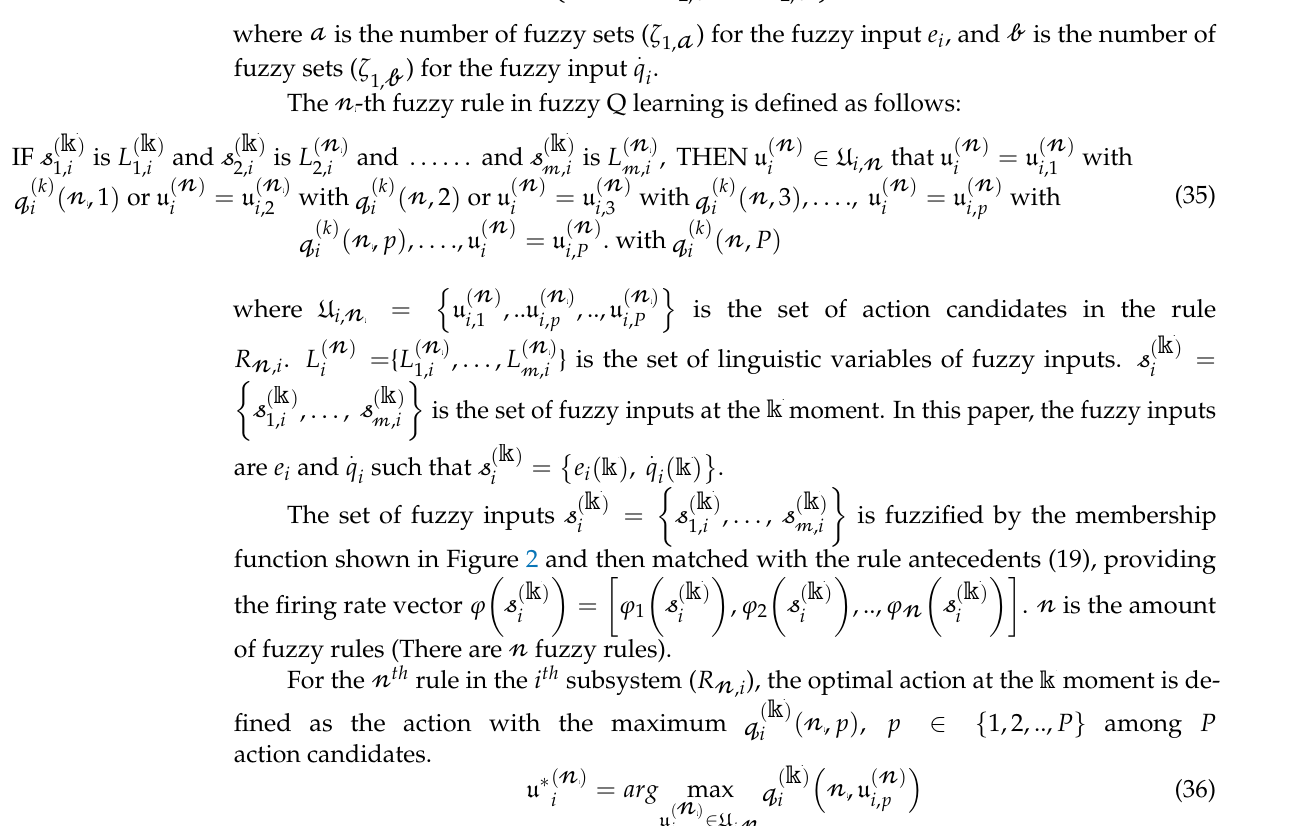
Figure 2. Membership function of fuzzy input of the 𝑖 (cid:3047)(cid:3035) subsystem. The parameters of membership function shown in Figure 2 are defined as follows: 𝐿𝑖𝑛(𝑒 (cid:3036) ) = (cid:4676)𝜁 (cid:2869),(cid:2869)((cid:3036)) , … , 𝜁 (cid:2869),𝒶((cid:3036)) , … , 𝜁 (cid:2869),𝒜((cid:3036)) (cid:4677), 𝒶 = 1,2, … , 𝒜 (33) 𝐿𝑖𝑛(𝑞(cid:4662) (cid:3036) ) = (cid:4676)𝜁 (cid:2870),(cid:2869)((cid:3036)) , … , 𝜁 (cid:2870),𝒷((cid:3036)) , … , 𝜁 (cid:2870),ℬ((cid:3036)) (cid:4677), 𝒷 = 1,2, … , ℬ (34) where 𝒜 is the number of fuzzy sets ( 𝜁 (cid:2869),𝒶 ) for the fuzzy input 𝑒 (cid:3036) , and ℬ is the number of fuzzy sets ( 𝜁 (cid:2869),𝒷 ) for the fuzzy input 𝑞(cid:4662) (cid:3036) . The 𝓃 -th fuzzy rule in fuzzy Q learning is defined as follows: 𝑅 𝓃,(cid:3036) : IF 𝓈 (cid:2869),(cid:3036)(𝕜) is 𝐿 (cid:2869),(cid:3036)(𝕜) and 𝓈 (cid:2870),(cid:3036)(𝕜) is 𝐿 (cid:2870),(cid:3036)(𝓃) and …… and 𝓈 𝓂,(cid:3036)(𝕜) is 𝐿 𝓂,(cid:3036)(𝓃) , THEN 𝔲 (cid:3036)(𝓃) ∈ 𝔘 (cid:3036),𝓃 that 𝔲 (cid:3036)(𝓃) = 𝔲 (cid:3036),(cid:2869)(𝓃) with 𝓆 (cid:3036) ( (cid:3038) ) (𝓃, 1) or 𝔲 (cid:3036) ( 𝓃 ) = 𝔲 (cid:3036),(cid:2870) ( 𝓃 ) with 𝓆 (cid:3036) ( (cid:3038) ) (𝓃, 2) or 𝔲 (cid:3036) ( 𝓃 ) = 𝔲 (cid:3036),(cid:2871) ( 𝓃 ) with 𝓆 (cid:3036) ( (cid:3038) ) (𝓃, 3) ,…., 𝔲 (cid:3036) ( 𝓃 ) = 𝔲 (cid:3036),(cid:3043) ( 𝓃 ) with 𝓆 (cid:3036)((cid:3038)) (𝓃, 𝑝) ,…., 𝔲 (cid:3036)(𝓃) = 𝔲 (cid:3036),(cid:3017)(𝓃) . with 𝓆 (cid:3036)((cid:3038)) (𝓃, 𝑃) (35) where 𝔘 (cid:3036),𝓃 = (cid:4676)𝔲 (cid:3036),(cid:2869)(𝓃) , . . 𝔲 (cid:3036),(cid:3043)(𝓃) , . . , 𝔲 (cid:3036),(cid:3017)(𝓃) (cid:4677) is the set of action candidates in the rule 𝑅 𝓃,(cid:3036) . 𝐿 (cid:3036)(𝓃) = { 𝐿 (cid:2869),(cid:3036)(𝓃) , … , 𝐿 𝓂,(cid:3036)(𝓃) } is the set of linguistic variables of fuzzy inputs. 𝓈 (cid:3036)(𝕜) = (cid:4676)𝓈 (cid:2869),(cid:3036)(𝕜) , … , 𝓈 𝓂,(cid:3036)(𝕜) (cid:4677) is the set of fuzzy inputs at the 𝕜 moment. In this paper, the fuzzy inputs are 𝑒 (cid:3036) and 𝑞(cid:4662) (cid:3036) such that 𝓈 (cid:3036)(𝕜) = {𝑒 (cid:3036) (𝕜), 𝑞(cid:4662) (cid:3036) (𝕜)} . The set of fuzzy inputs 𝓈 (cid:3036)(𝕜) = (cid:4676)𝓈 (cid:2869),(cid:3036)(𝕜) , … , 𝓈 𝓂,(cid:3036)(𝕜) (cid:4677) is fuzzified by the membership function shown in Figure 2 and then matched with the rule antecedents (19), providing the firing